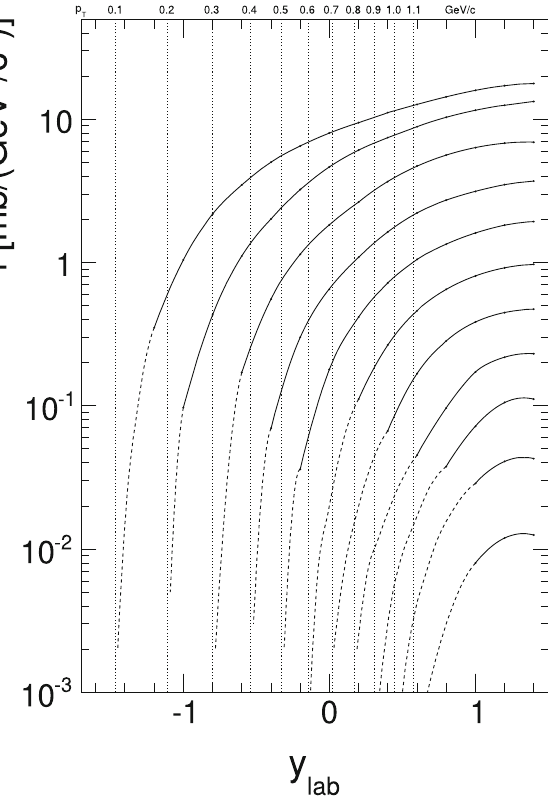
Fig. 116 f ( y lab , p T ) as a function of y lab for p T values between 0.1 and 1.1 GeV/c in steps of 0.1 GeV/c and log ( s ) = 1.2. For each p T the corresponding y min is indicated as a vertical line lab